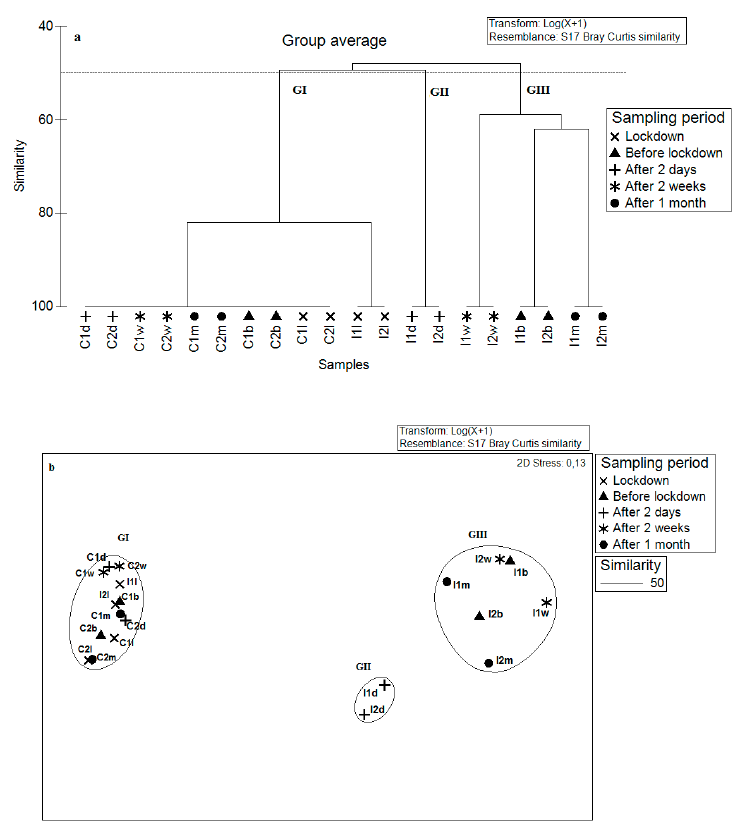
Figure 6. Dendrogram ( a ) and n-MDS ordination plot ( b ) of Bray–Curtis similarities from abun- dance data (Log (x + 1) transformation) for impacted (I1 and I2) and control (C1 and C2) sampling before lockdown (b); during lockdown (l); and after two days (d), two weeks (w), and one month (m) of deconfinement. Three groups of stations are identified by cluster analysis at a 50% similarity level.